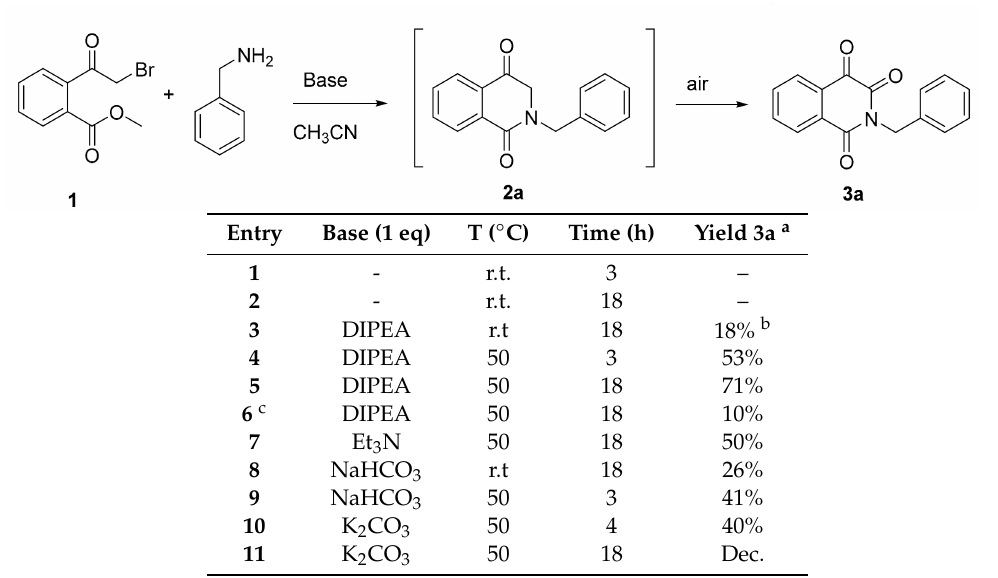
Table 1. Preliminary reaction conditions